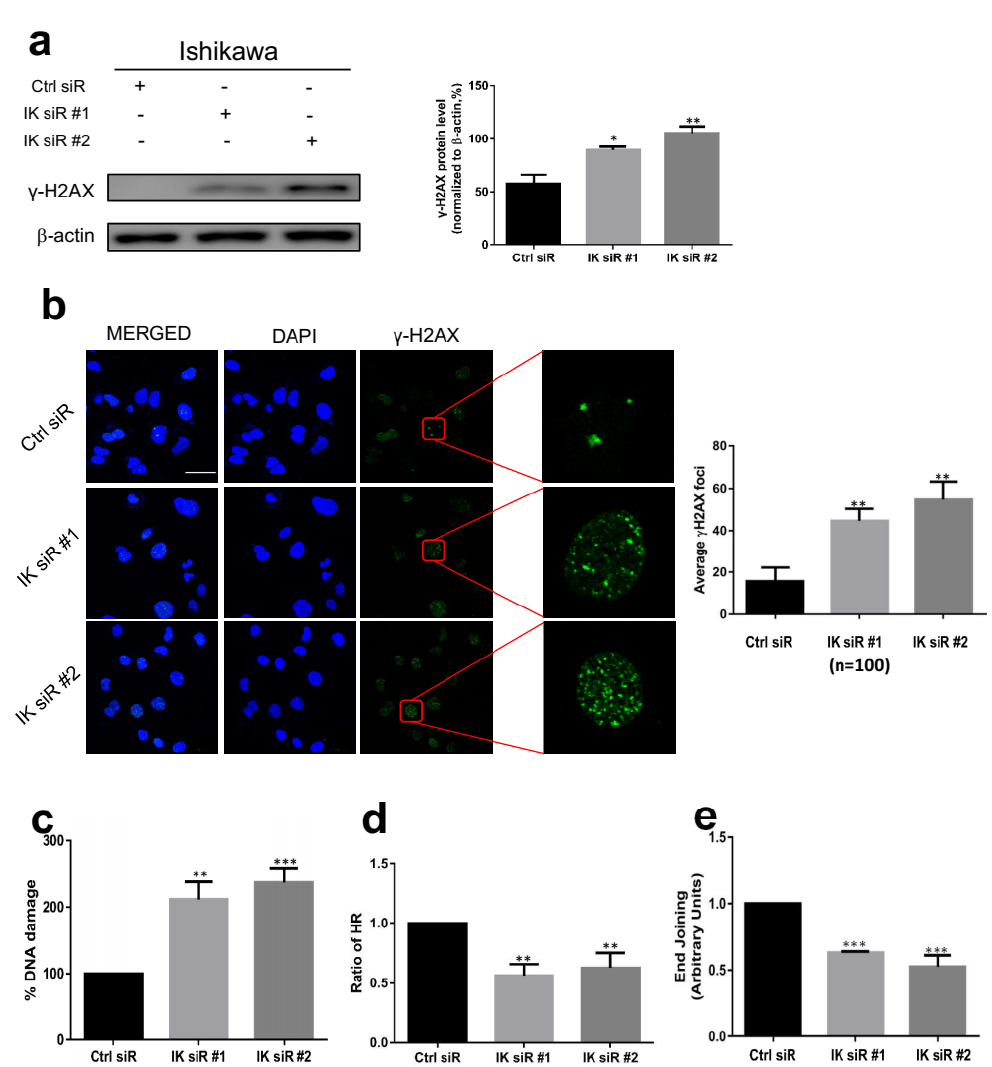
Figure 4. IK knockdown leads to inactivation of DNA repair signaling. ( a ) (Left) Seventy-two hours after IK siRNA transfection in Ishikawa cells, γ -H2AX expression increased. (Right) Quantitative analysis of γ -H2AX protein expression. ( b ) (Left) Seventy-two hours after IK siRNA transfection, IK attenuation caused more γ -H2AX foci. (Right) Quantification of average γ -H2AX foci per cell. ( c ) Seventy-two hours after IK siRNA transfection, IK attenuation caused more DNA damage. ( d ) Seventy-two hours after IK siRNA transfection, IK attenuation weakened HR efficiency. ( e ) Seventy-two hours after IK siRNA transfection, we measured end joining in Ishikawa nuclear extracts of different groups with qPCR; IK attenuation weakened NHEJ efficiency. Mean ± SD of at least three independent experiments (two-sided Student’s t test, * p < 0.05, ** p < 0.01, *** p < 0.001).